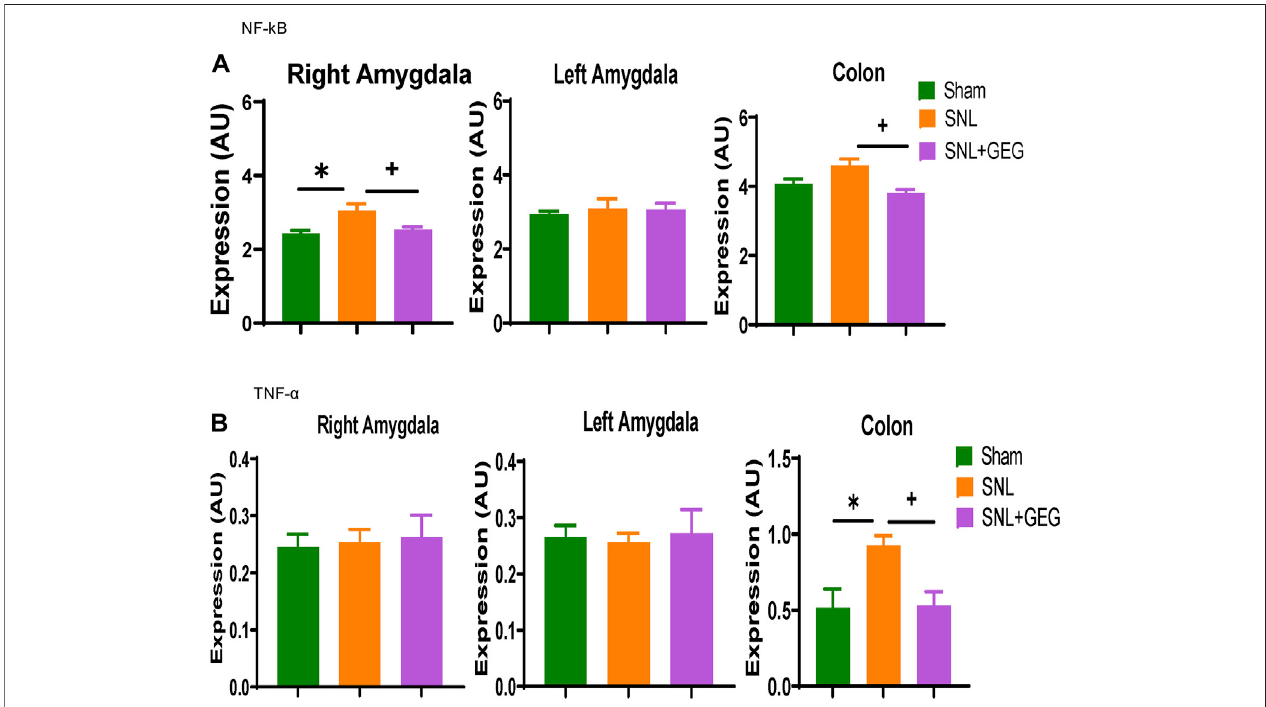
FIGURE 6 | Effect of GEG supplementation on mRNA expression of NF- κ B (A) and TNF- α (B) in the right amygdala, left amygdala, and colon of SNL rats. Data is expressed as mean ± SEM. n = 5-6 per group. Data was analyzed by one-way ANOVA followed by a post hoc Tukey ’ s test. * p < 0.05 vs Sham. + p < 0.05 vs SNL.